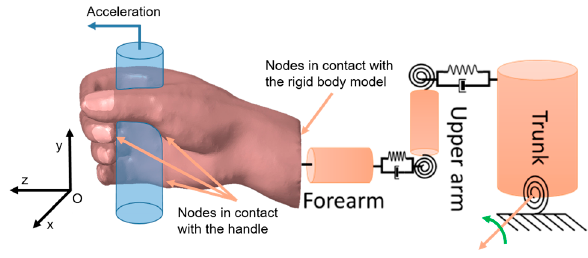
Figure A1. Boundary conditions and loading of the finite element models.